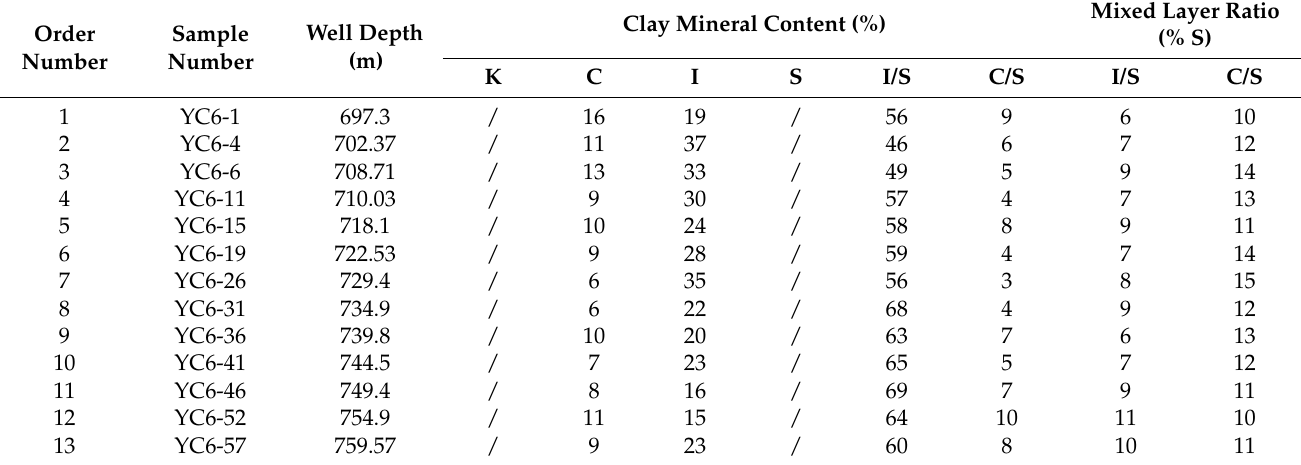
Table 2. X-ray diffraction (XRD) data of shale clay